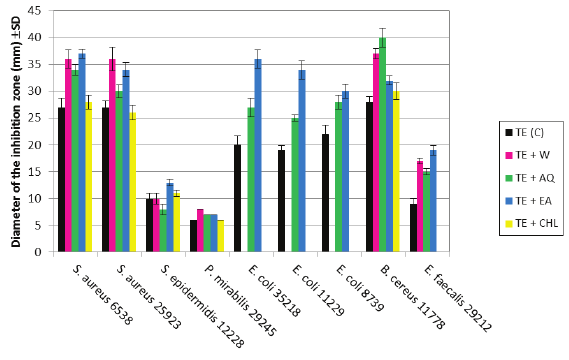
Figure 3: Bacterial strains response to Tetracycline/TE combinations with the four Arctii folium extracts (TE+W, TE+AQ, TE+EA, and TE+CHL) comparatively to the antibiotic alone, TE (C); diameter of the inhibition zone, (mm) ± SD.